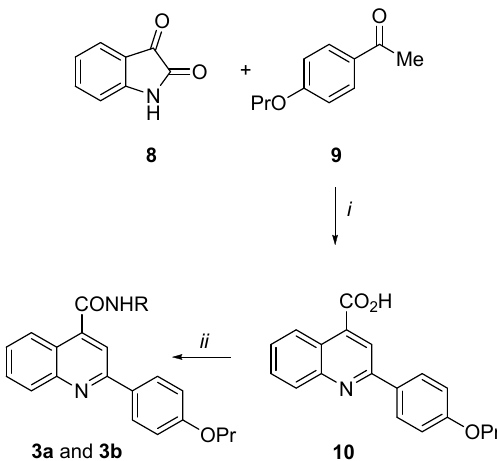
that are highlighted in red. The chemical features of ModB and ModC are shown in green and yellow, respectively. a Fitness